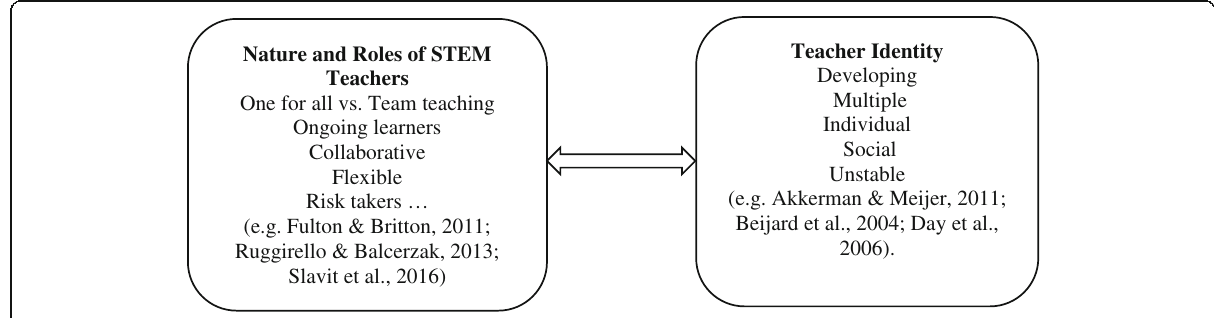
Fig. 1 The interaction between assumed roles of STEM teachers and the aspects/attributes of teacher